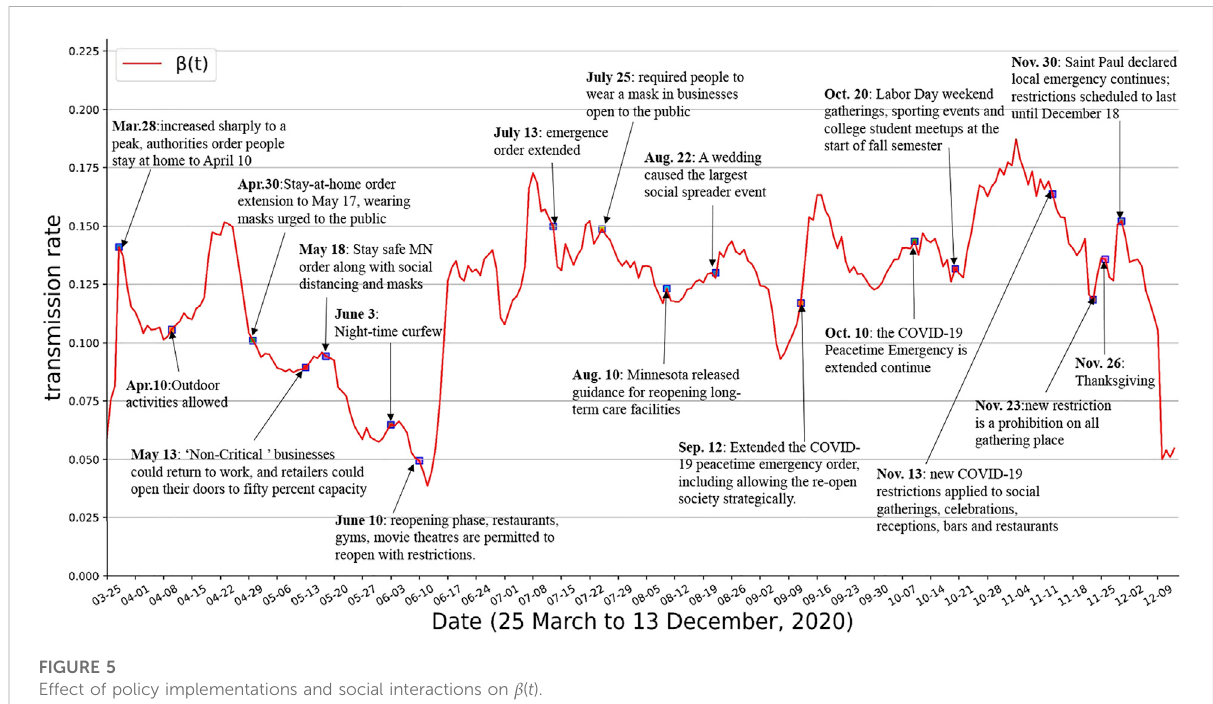
FIGURE 5 Effect of policy implementations and social interactions on β ( t